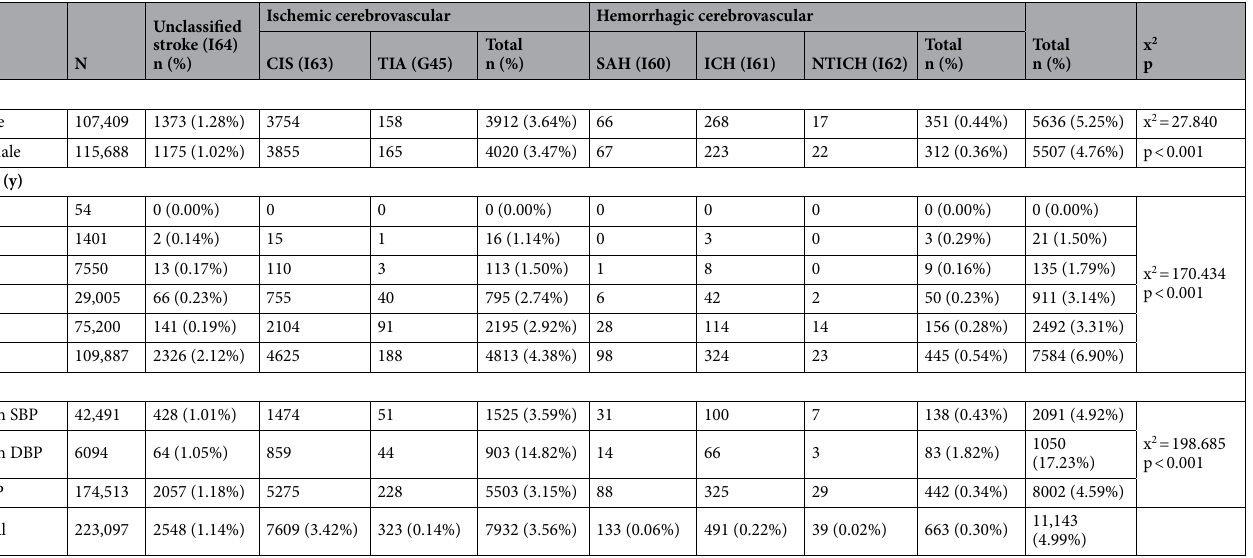
Table 1. Cumulative incidence of cerebrovascular diseases in hypertensive patients with different sex, age and blood pressure type (n, %). TIA transient ischemic attack, CIS cerebral ischemic stroke/cerebral infarction, TIA transient ischemic attack, SAH subarachnoid hemorrhage, ICH intracerebral hemorrhage, NTICH non- traumatic intracranial hemorrhage, n (%) number (complication rate %), High SBP only high systolic blood pressure, High DBP only high diastolic blood pressure, HBP high systolic and diastolic blood